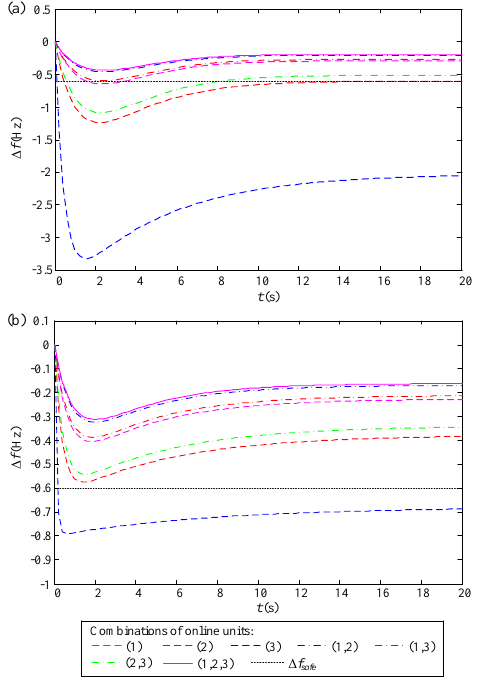
Figure 5. The system frequency responses for different combinations of online generation units. ( a ) Without DR; ( b ) With 20MW DR for the frequency